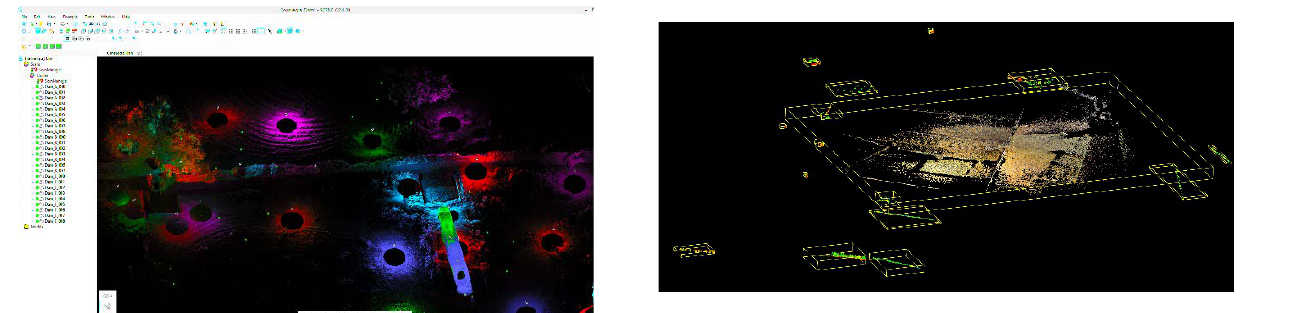
Figure 5. Labeled Connected Components segmentation tool in